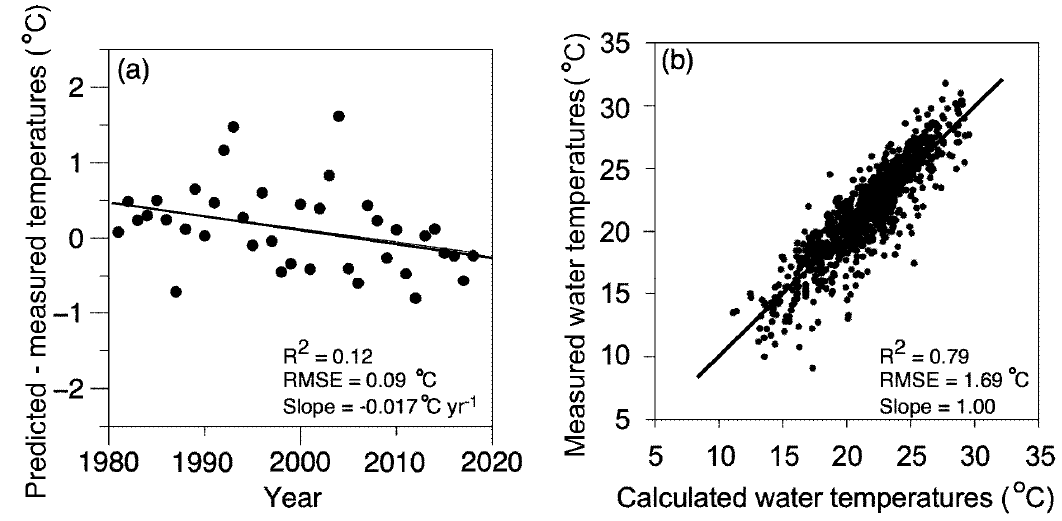
Figure 2. ( a ) Average annual di ff erence between predicted [16] and measured water temperatures versus years. ( b ) Measured daily water temperatures versus calculated water temperatures for United States lakes found in the National Water Quality data set for the years 1981 through 2018. Calculated temperatures were found with Equations (1)–(4).